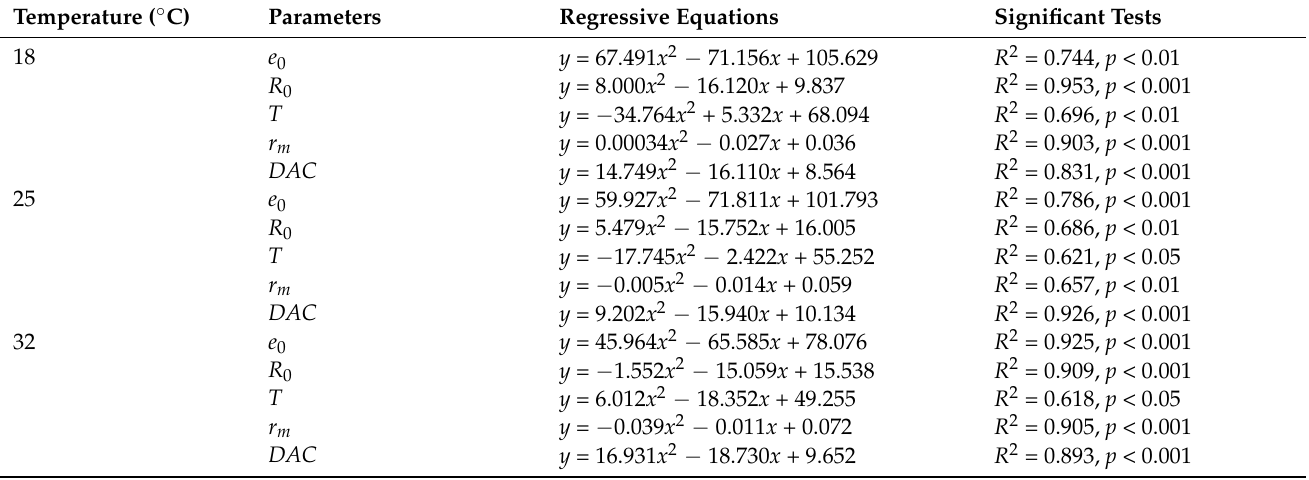
Table 2. The relationships between chlorpromazine concentration ( x , mg/L) and life expectancy at hatching ( e 0 ), generation time ( T ), net reproductive rate ( R 0 ), intrinsic rate of population increase ( r m ) and dopamine concentration ( DAC ) of B. calyciflorus at three